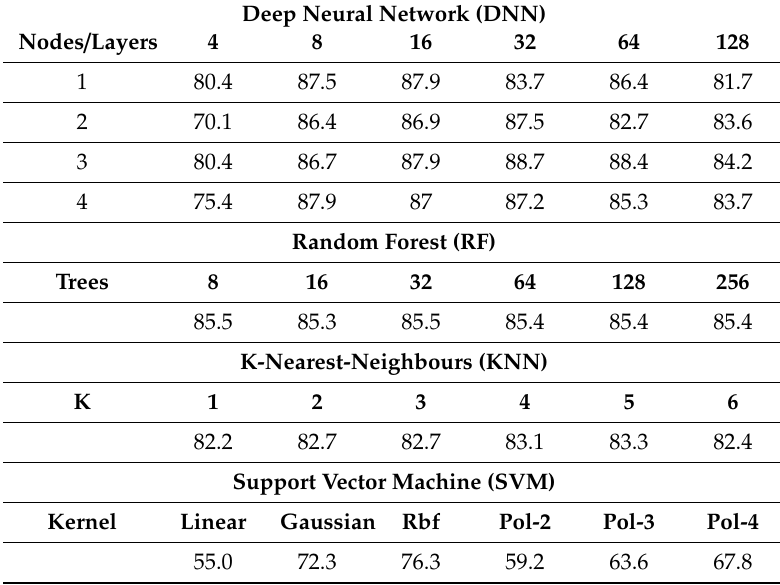
Table 2. Parameterization results E ACC (%) for four di ff erent classifiers, namely, Deep Neural Networks ( DNNs ), Random Forest ( RFs ), K-Nearest-Neighbors ( KNNs ), and Support Vector Machines ( SVMs